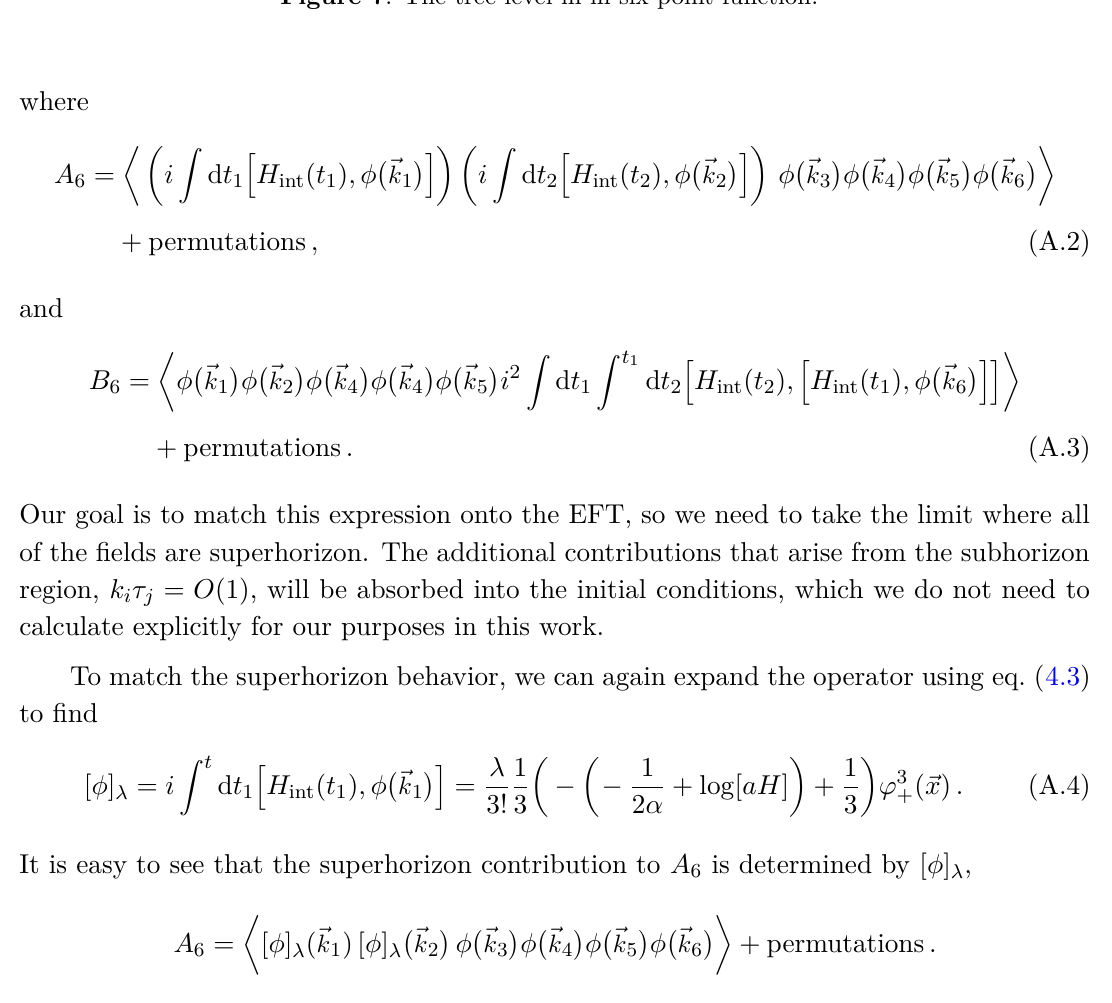
Figure 7 . The tree level in-in six-point